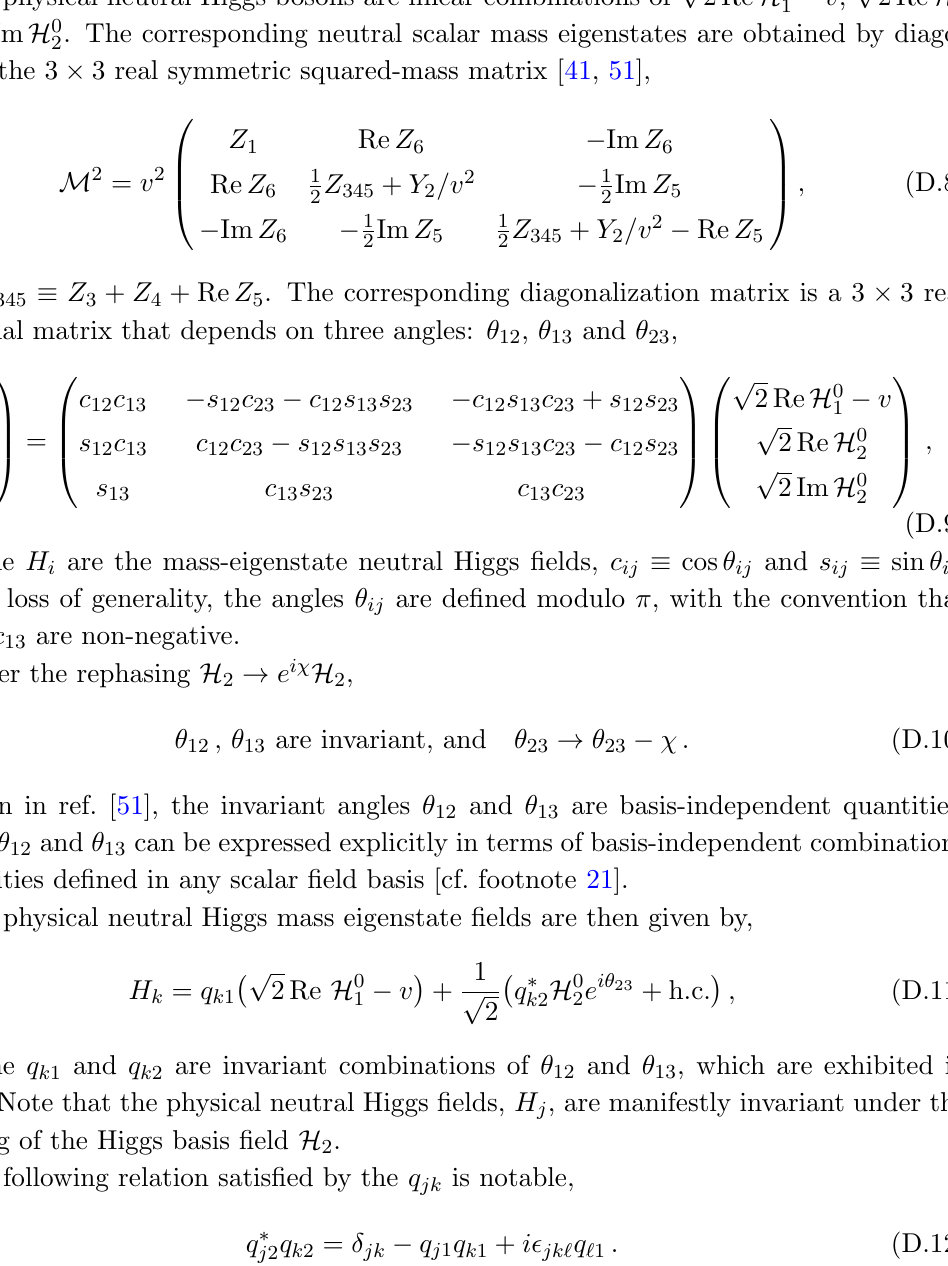
p p 2 Re H 0 (cid:0) v , 2 Re H 0 1